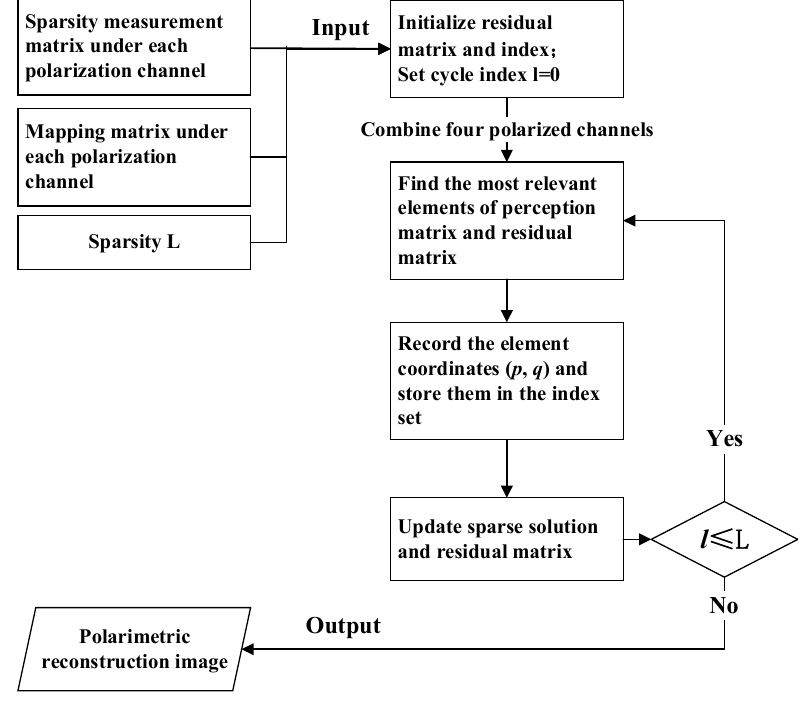
Figure 6. Flow chart of reconstruction algorithm.